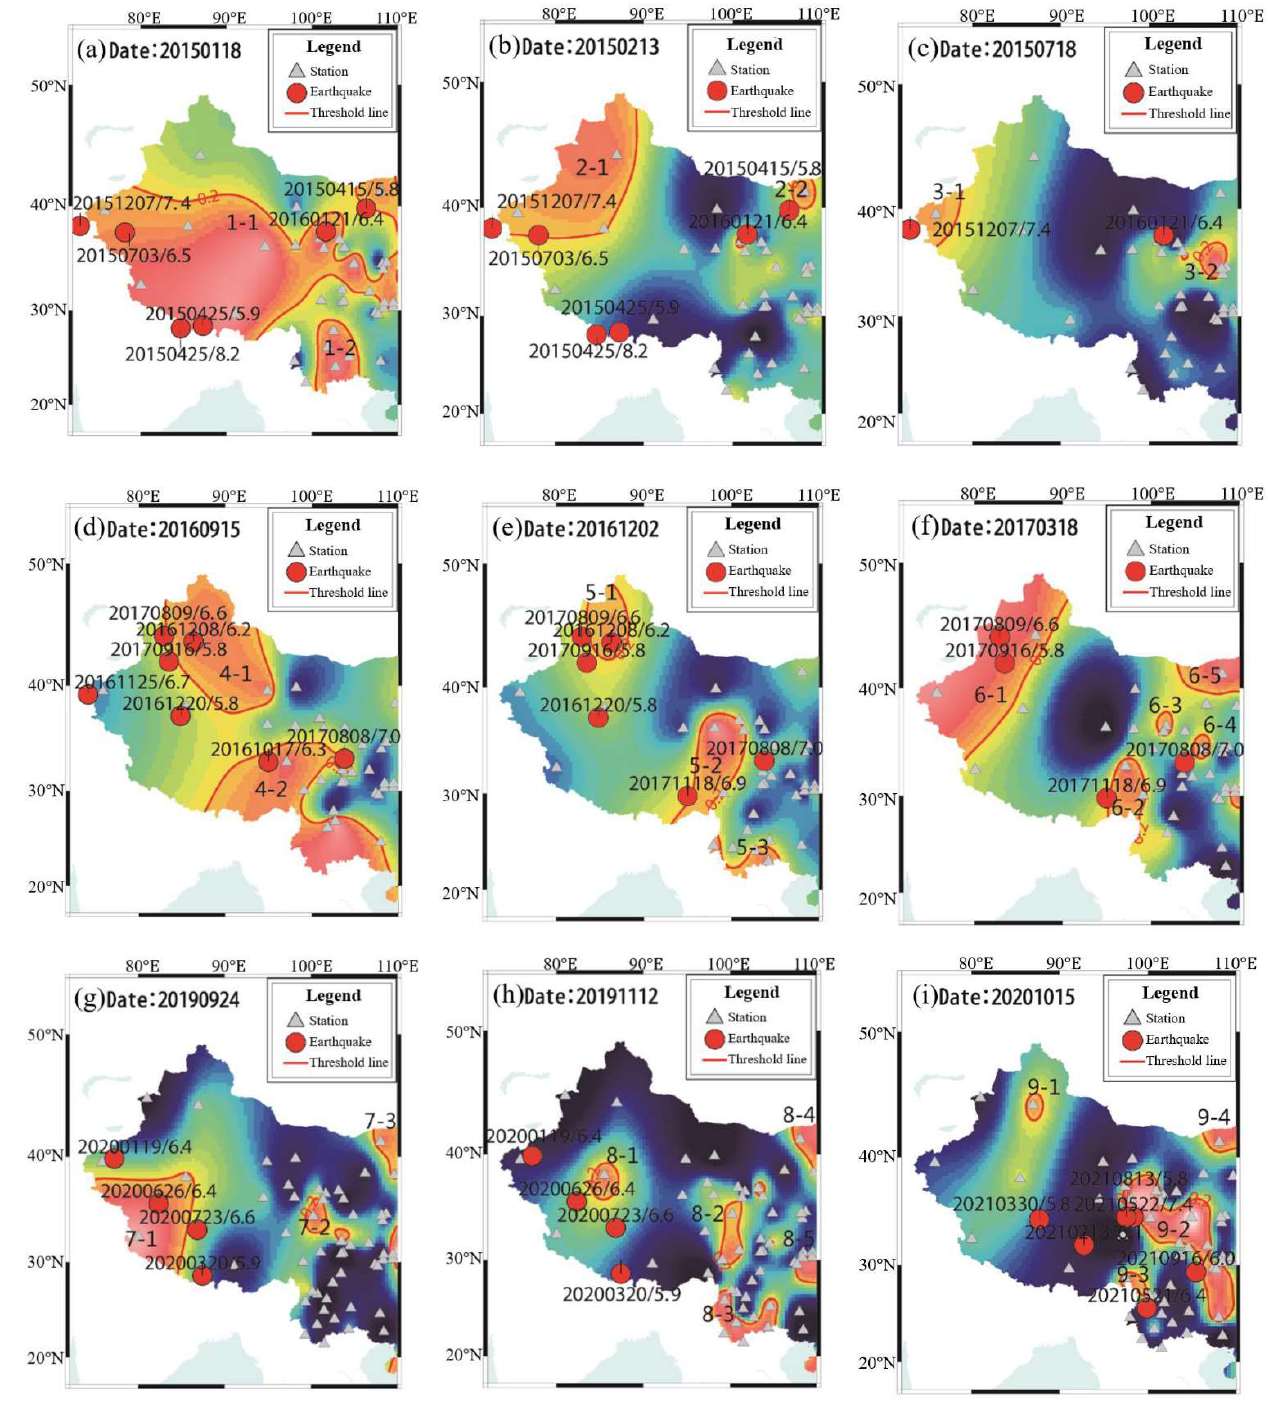
Figure 2. Geomagnetic vertical intensity polarization anomalies and spatial distributions of earth- quakes in the following years: ( a ) 20150118; ( b ) 20150213; ( c ) 20150718; ( d ) 20160915; ( e ) 20161202; ( f ) 20170318; ( g ) 20190924; ( h ) 20191112; ( i ) 20201015.